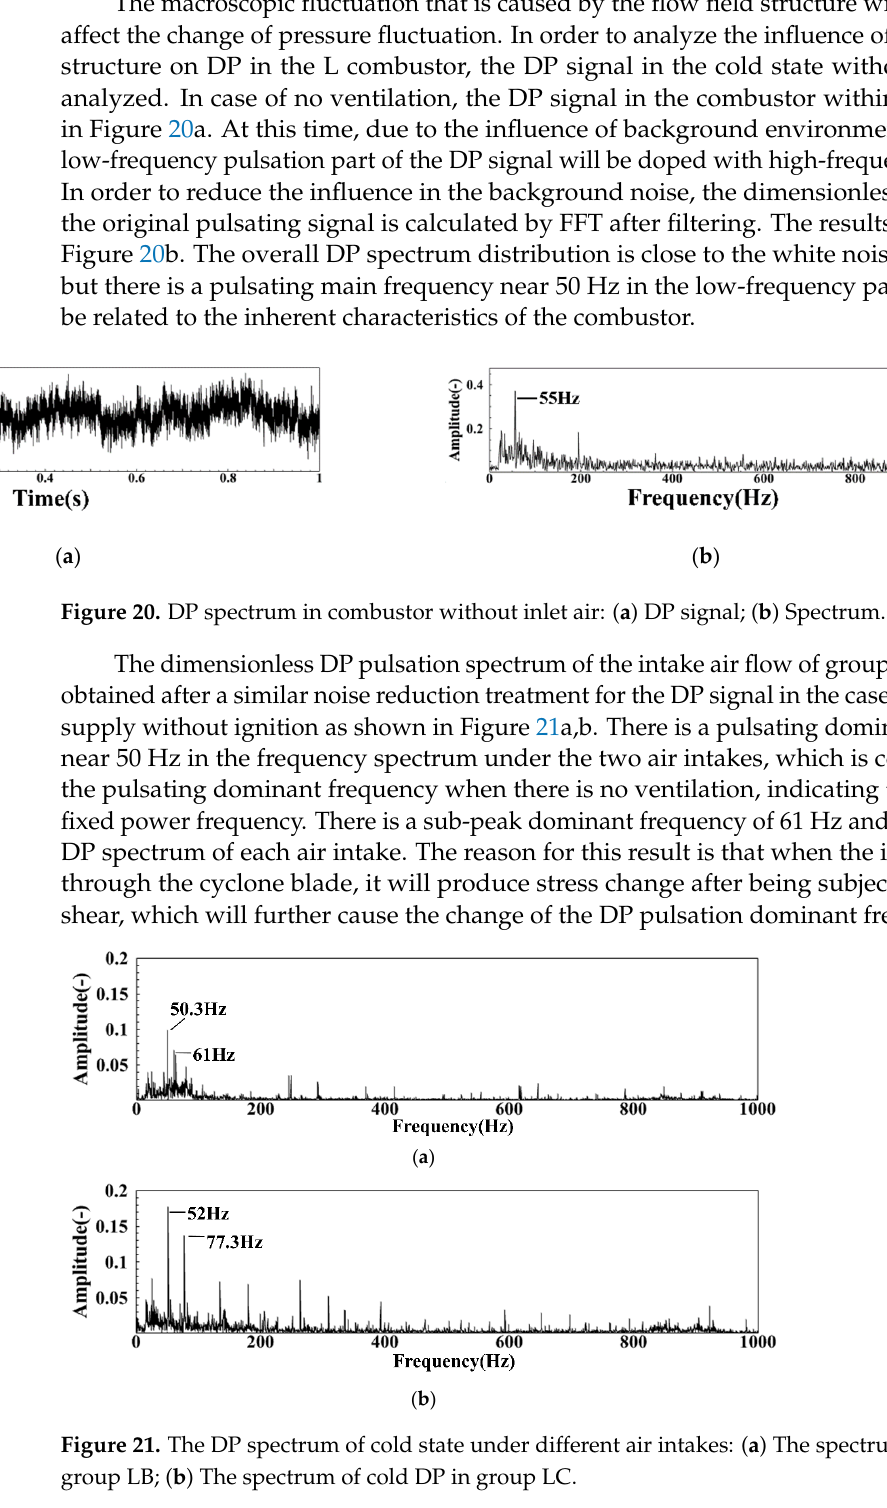
proximately consistent with IMF2 above, indicating that IMF2 contains the macroscopic pulsation information of cold flow field structure.